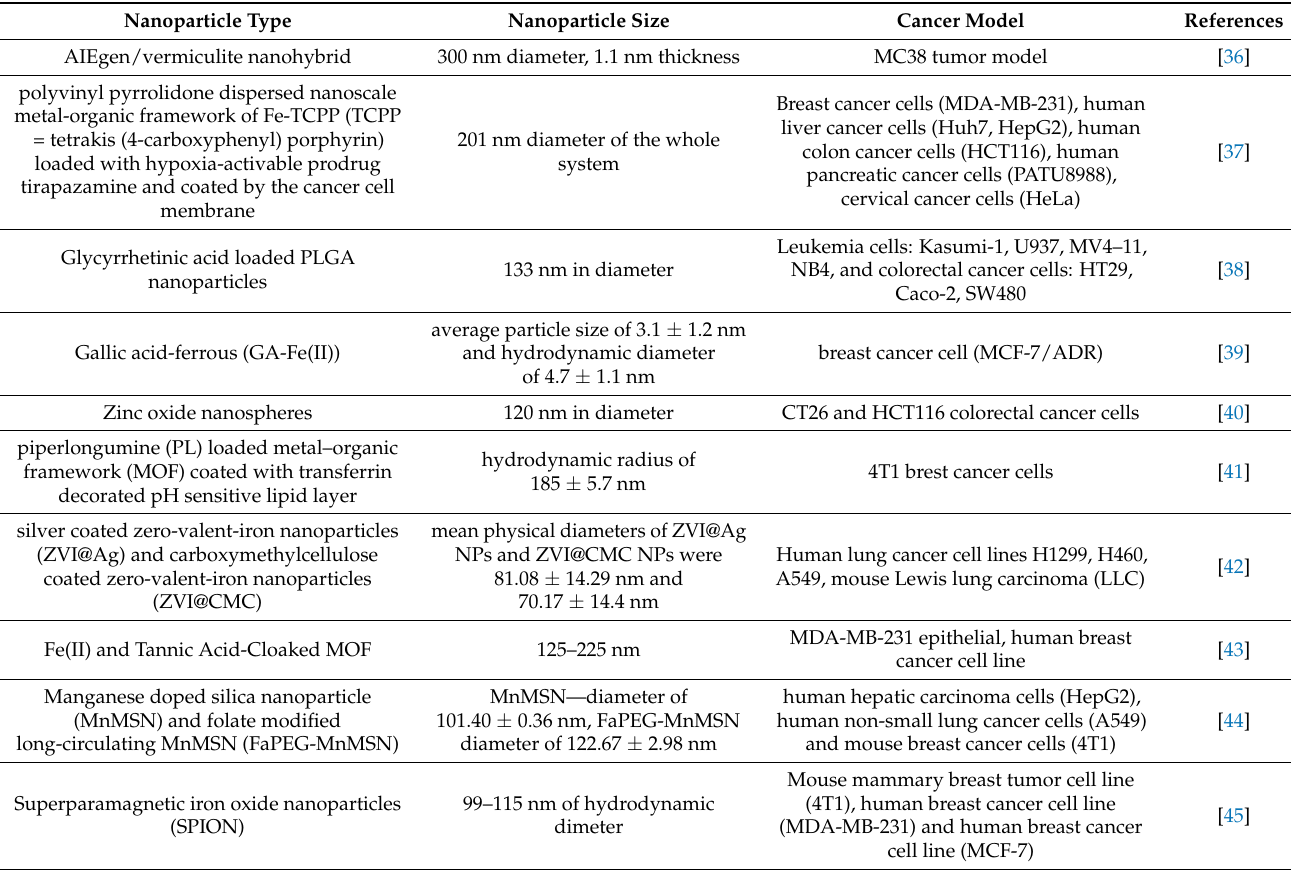
Table 1. Nanoparticle-based approach aimed to trigger